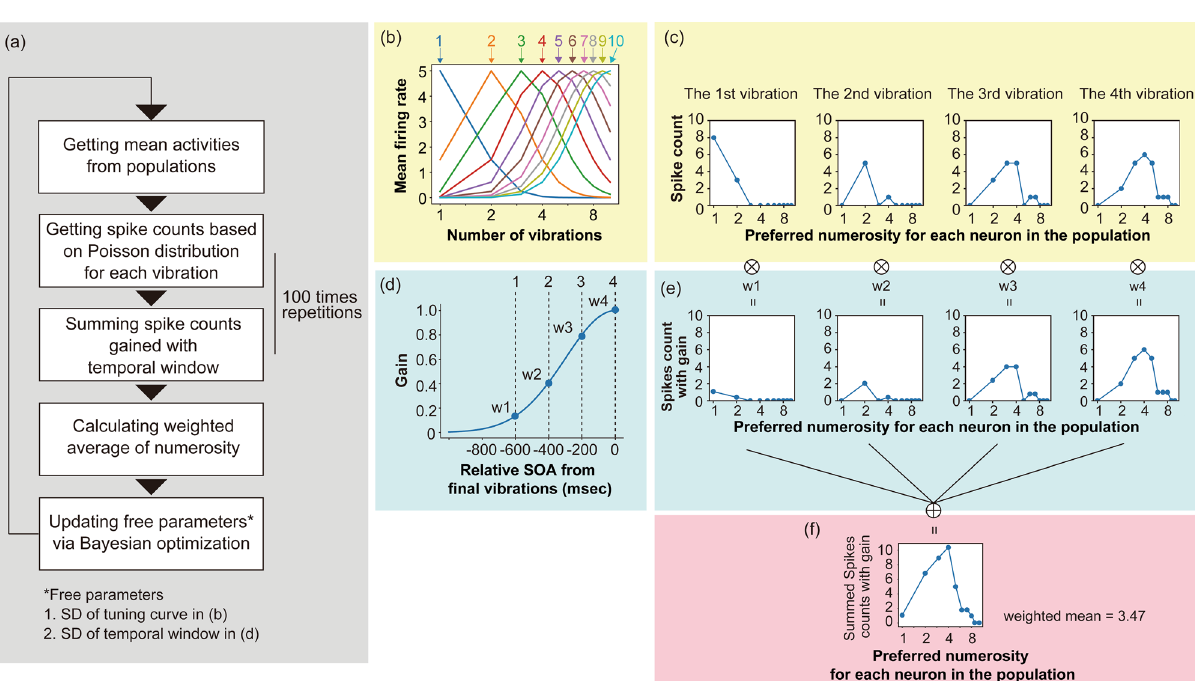
Figure 3. ( a ) A pipeline of processing steps in our model. ( b ) Tuning curves of the population of neurons that are selective to number. Here the standard deviation (SD) of the tuning curves is set at 0.6. ( c ) Spike count that was determined on the basis of Poisson randomness. The Poisson distribution that was used for the determination of the spike count of each neuron had a mean value that was drawn from each tuning curve. ( d ) A schematic explanation of temporal window and gain (w1, w2, w3, and w4). Here the SD of the temporal window is set at 300 ms. ( e ) Spike count with gain. ( f ) Summed version of spike count with gain as a function of preferred numerosity for each